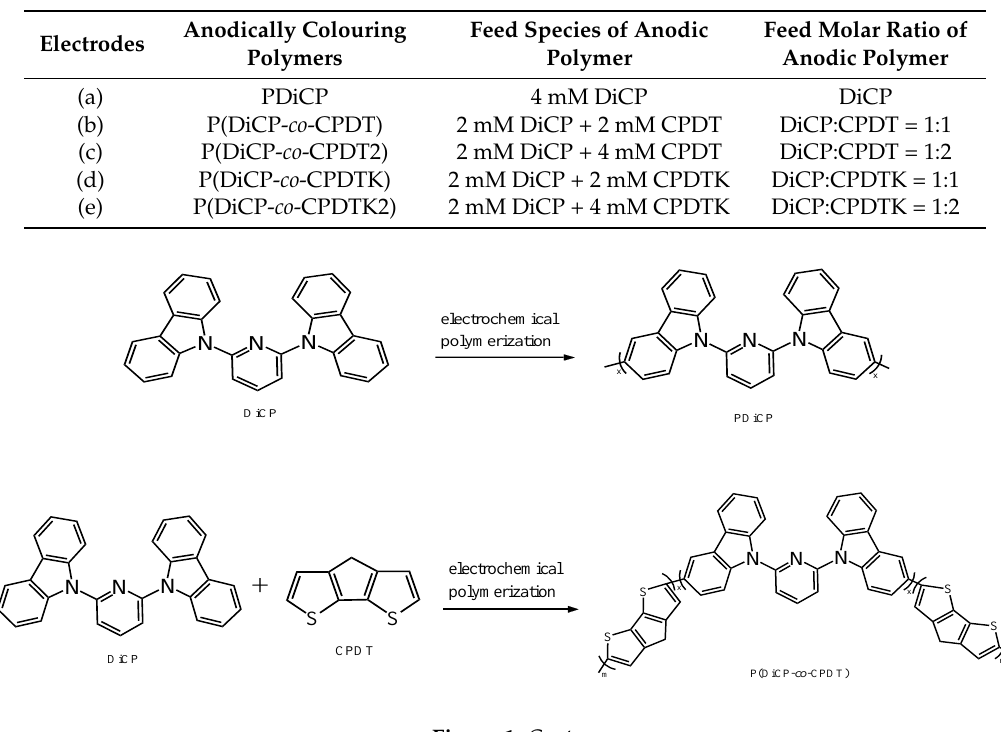
Table 1. Feed species of anodically-colouring polymers (a)–(e).